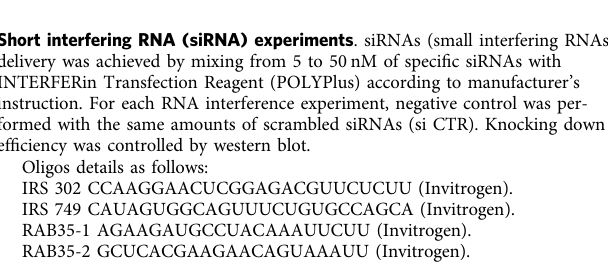
Cyst Matrigel/collagen culture . Caco-2 cells were trypsinized to a single cell suspension at 6 × 10 4 cells/ml and mixed with 20 mM HEPES pH7.5, 1mg/ml